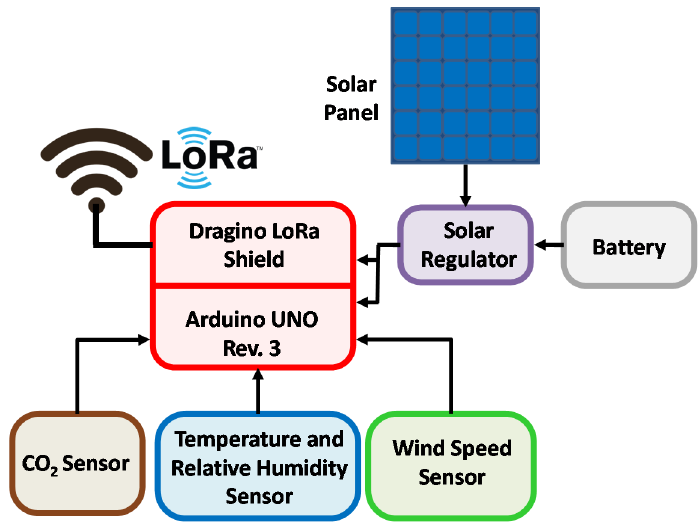
Figure 7. Block Diagram of node components.